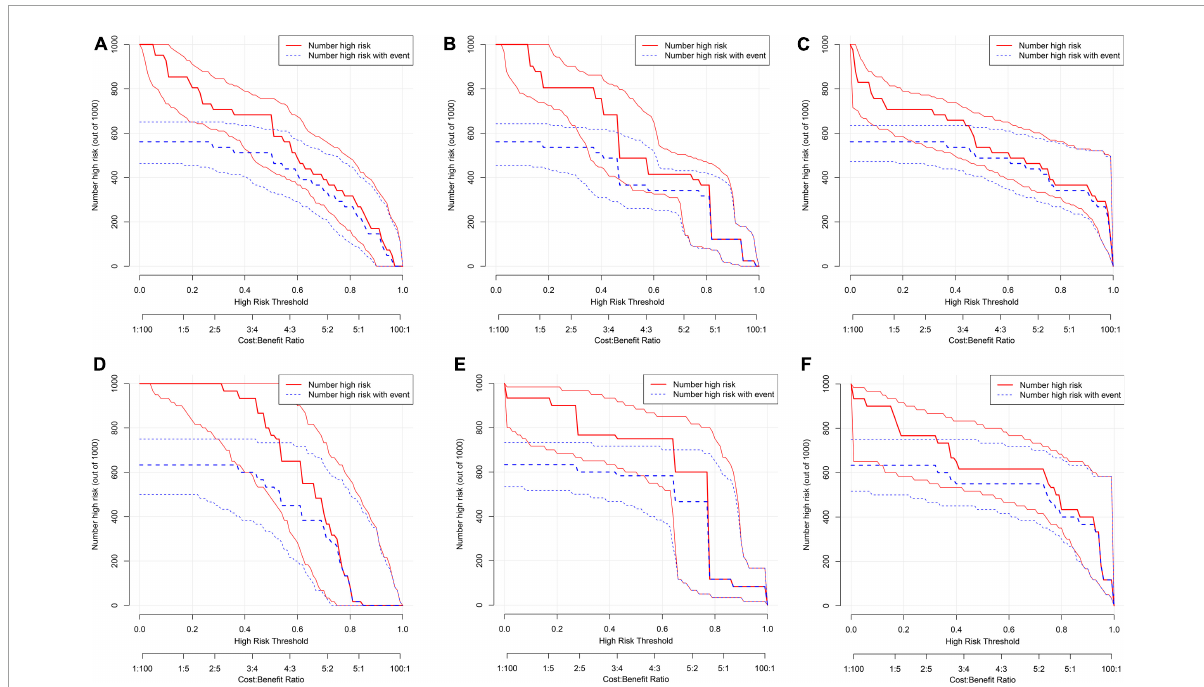
FIGURE6 Clinical impact curve (CIC) for PSCI nomogram. (A–C) Development cohort: model 1 (A) , model 2, (B) model 3 (C) ; (D–F) validation cohort: model 1 (D) , model 2 (E) , model 3 (F) . The red curve (number of high-risk individuals) indicates the number of people who are classified as positive (high risk) by the model at each threshold probability; the blue curve (number of high-risk individuals with outcome) is the number of true positives at each threshold